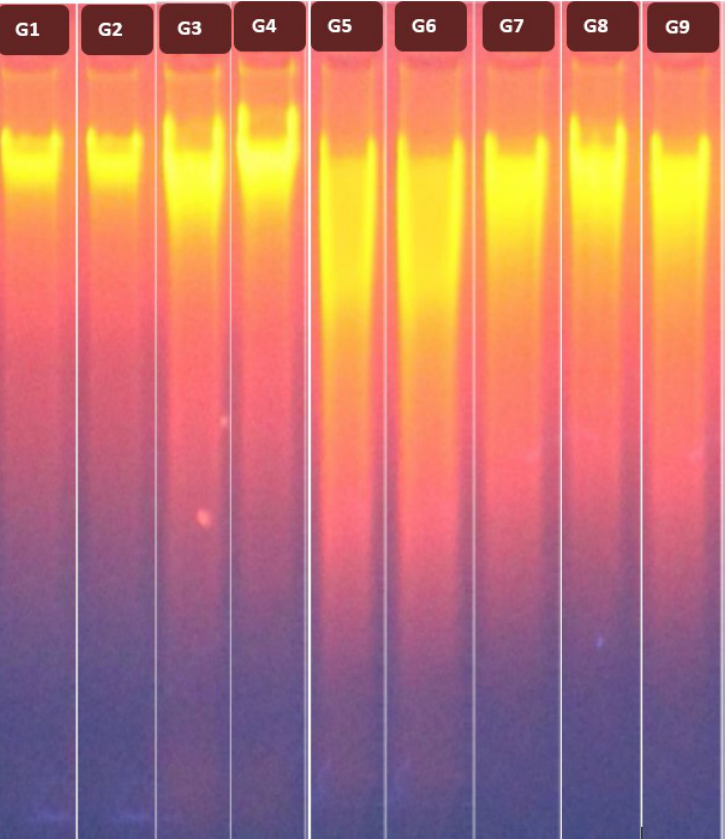
Figure 4. Effect of different compounds on DNAF. Ethidium bromide-stained agarose gel showing fragmentation patterns of the extracted DNA in the studied groups. G1: control, G2: CSNPs, G3: DBT, G4: DBT–CSNPs, G5: CCl 4 , G6: CCl 4 -CSNPs, G7: CCl 4 -DBT, G8: CCl 4 -DBT–CSNPs, and G9: CCl 4